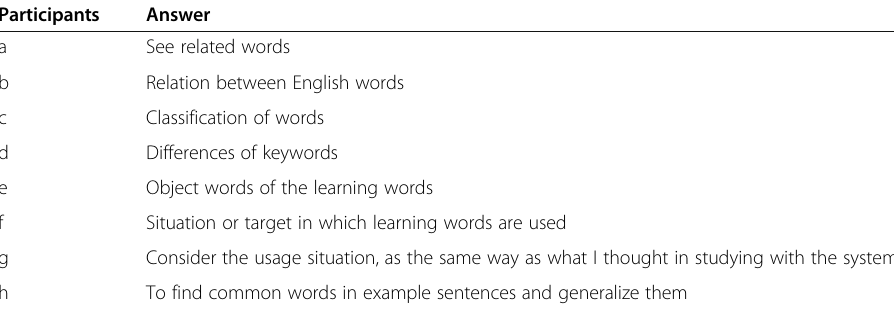
Table 7 Answer of questionnaire item 1